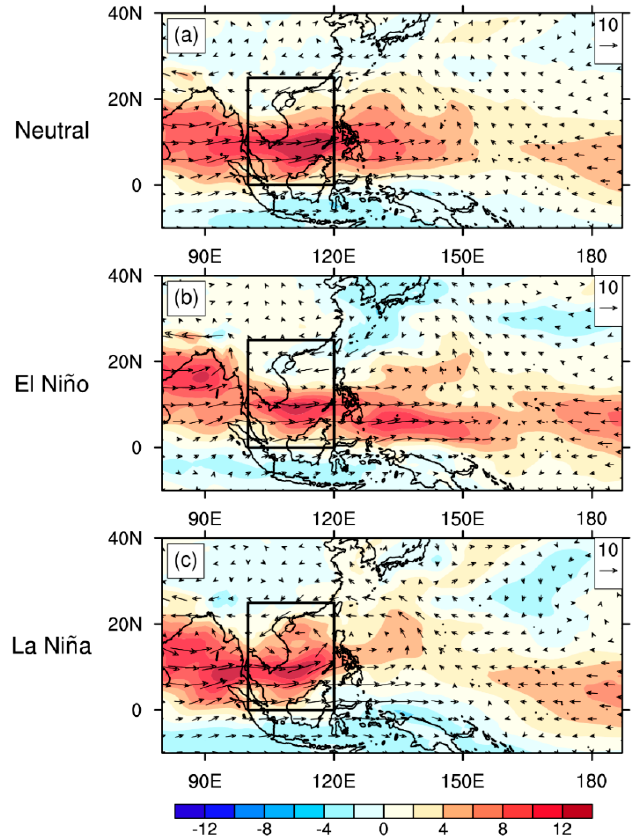
Figure 10. Di ff erences between the composites of filtered water vapor flux anomaly vertically integrated from 1000 to 500 hPa (vectors; unit: kg · m − 1 · s − 1 ) for the active and inactive MJO phases over the SCS during June–November over the period of 1979–2016, overlaid with the related magnitude of filtered water vapor flux anomaly (shaded; unit: kg · m − 1 · s − 1 ) in ( a ) neutral years, ( b ) the El Niño years, and ( c ) the La Niña years. The definition of the active and inactive phases for the MJO-related SCS TC genesis under di ff erent ENSO conditions is in Table 1.